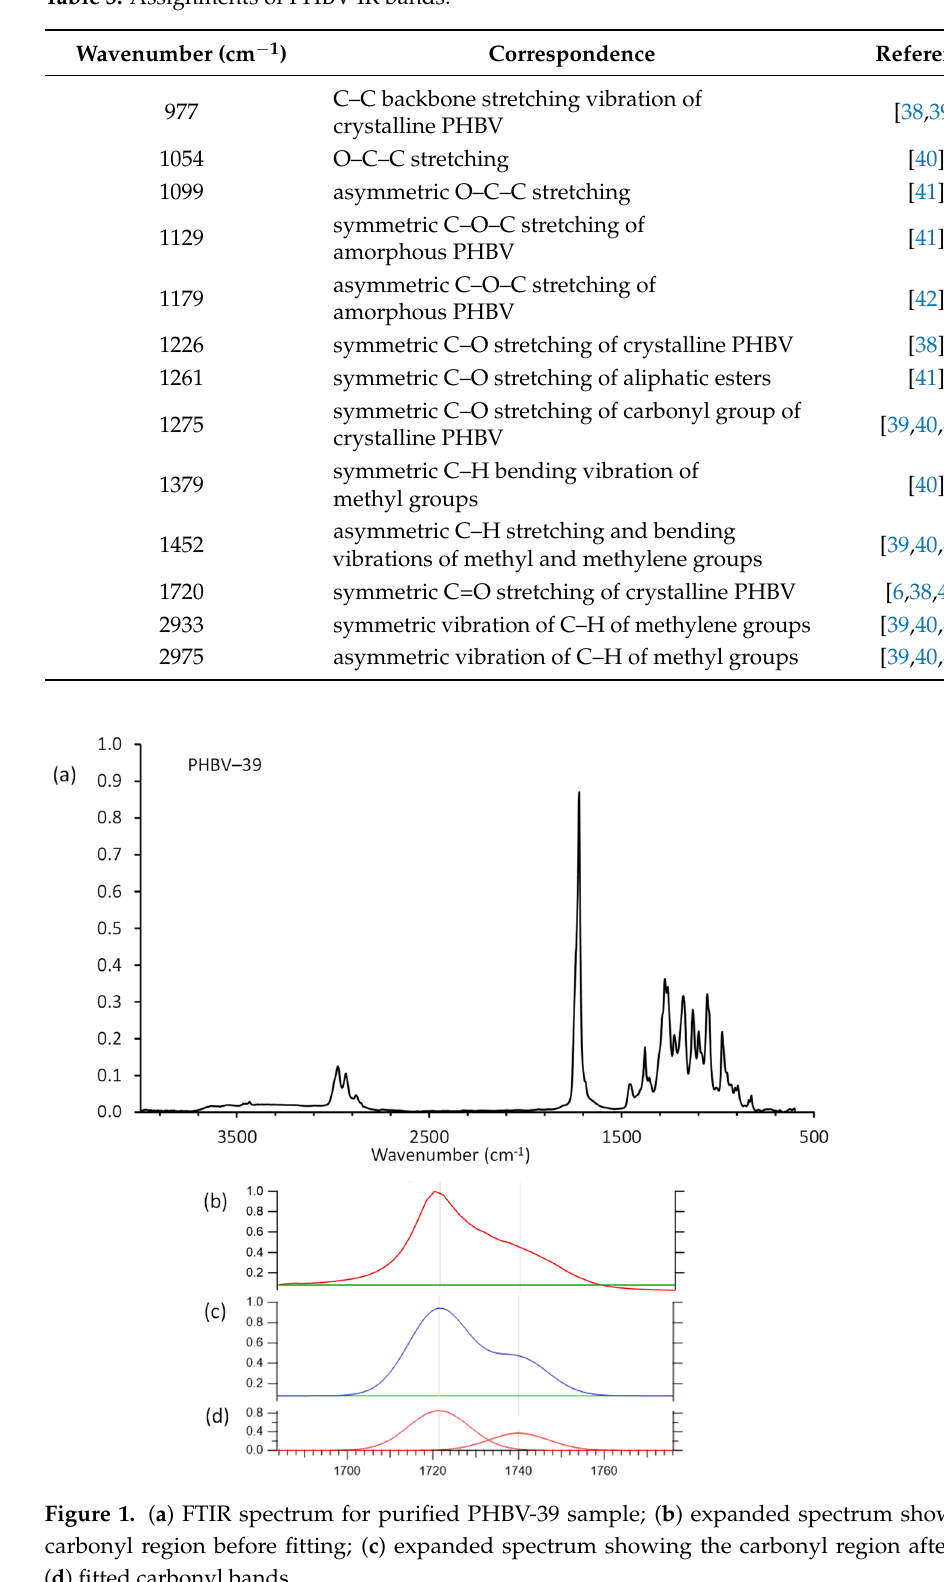
Table 3. Assignments of PHBV IR bands.